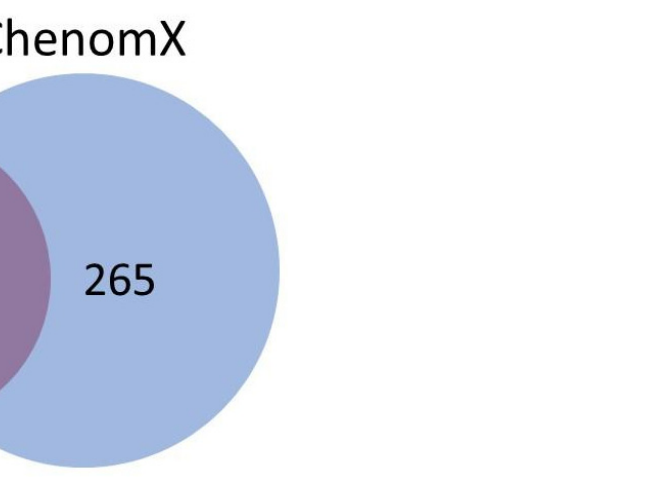
Figure 6. Venn diagram showing source of identified metabolites from BML (red) and ChenomX (blue). Table 2. Metabolites associated with muscle catabolic and anabolic pathways.